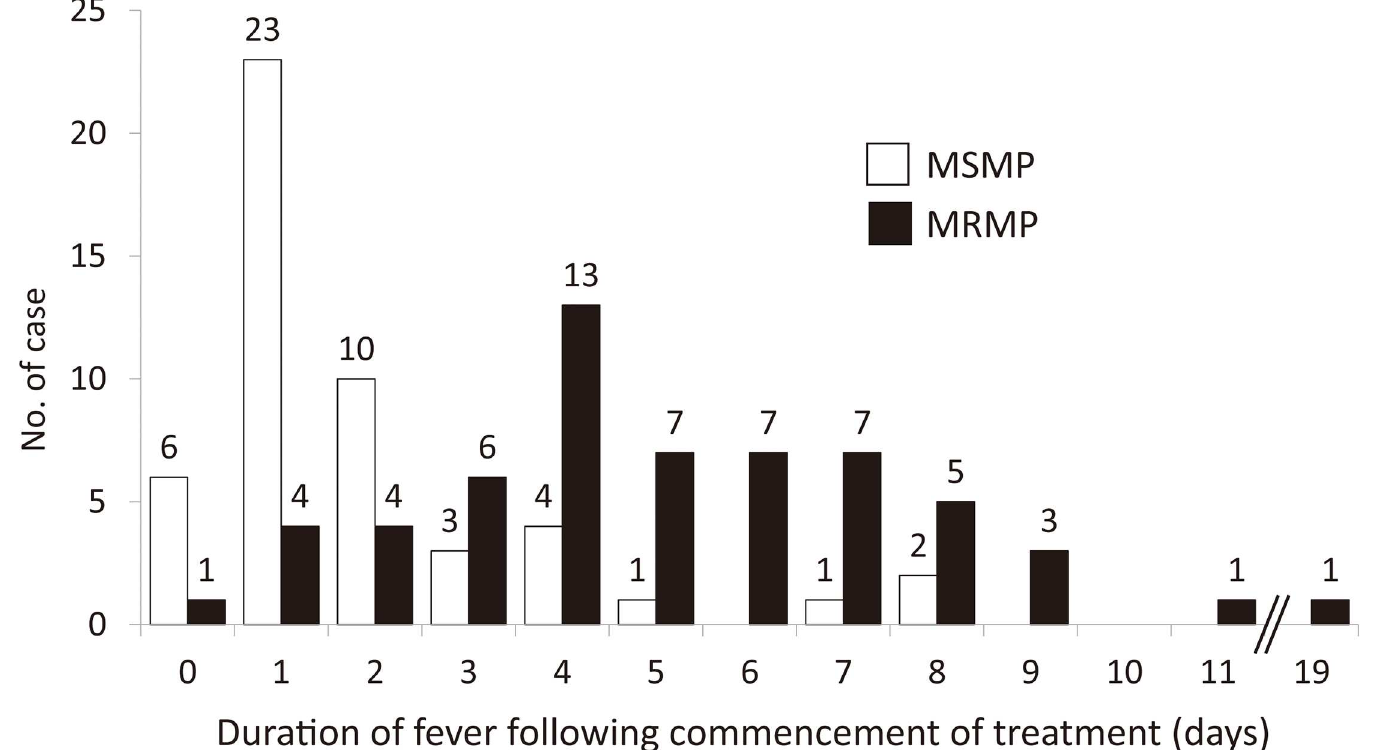
Fig 3. Durations of fever following commencement of treatment for pneumonia due to MRMP and MSMP. Histograms showingthe durationsof fever followingcommencement of treatment for pneumonia due to MRMP (black bar) and pneumonia due to MSMP (white bar).